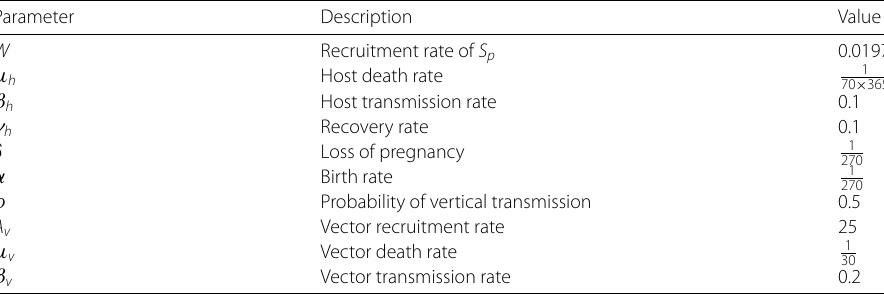
Table 3 Model parameters used for numerical